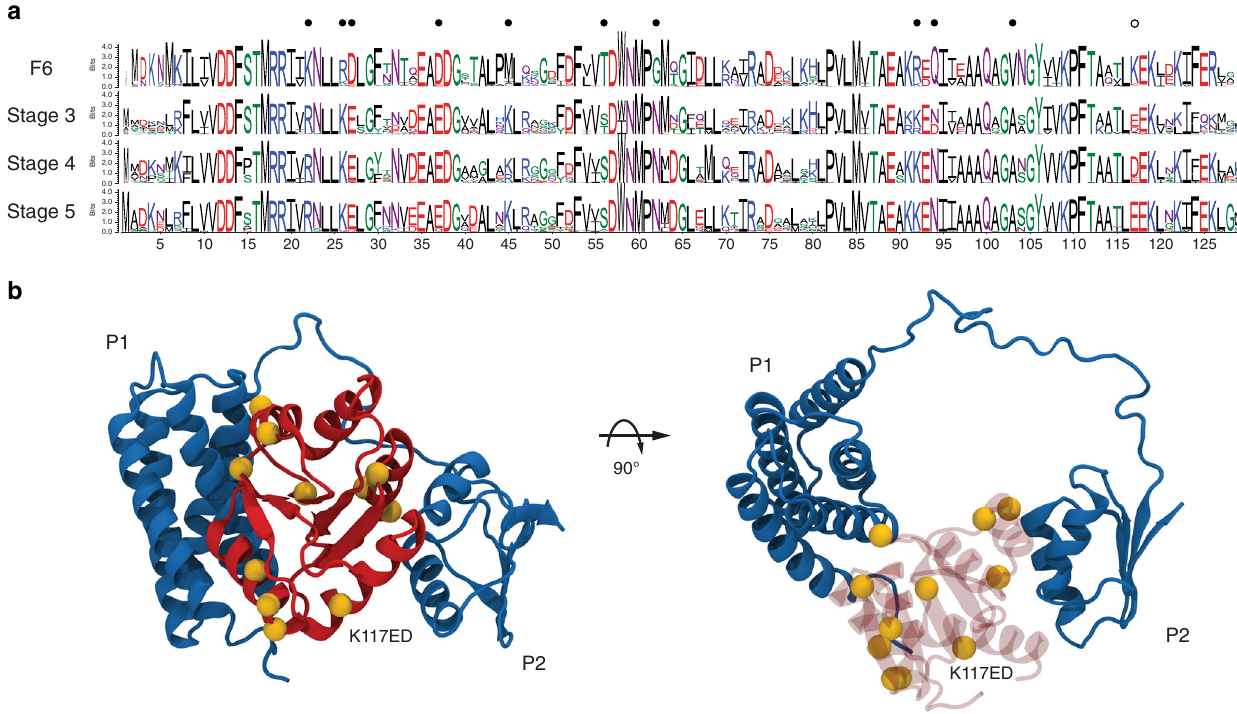
Fig. 5 Adaptation of CheY-F6 to function with F7 systems in stages 3 – 5. a Comparison of the sequence logos of the CheY proteins from the F6 system and CheY-F6-like present in genomes with 3 – 5 F7 systems. The amino-acids are color coded according to their chemical properties: neutral (purple), polar (green), positive charge (blue), negative charge (red), and hydrophobic (black). The dots mark conserved positions within each group that are similar between stages 3 – 5 but in the group of CheY-F6. b The alpha carbons (yellow spheres) of these positions are mapped in the structure of CheY (red) bound to the P1 and P2 domains of CheA (blue). From the ten positions that matched our criteria, only two of them were not located at an interface with CheA (M45K and T56S). Three residues are facing P2 (R92K, Q94N, and V103A) and fi ve are facing P1 (K22R, R26K, D27E, D37E, and G62N). Note that the numbers refer to the coordinates of the E. coli